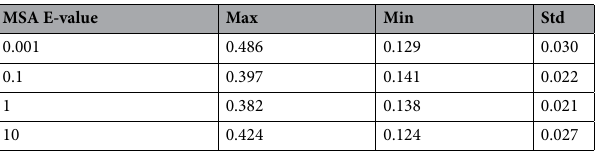
Table 2. Statistics of attention weights given to different E-value based features averaged over 43 CASP13 FM and FM/TBM domain targets.